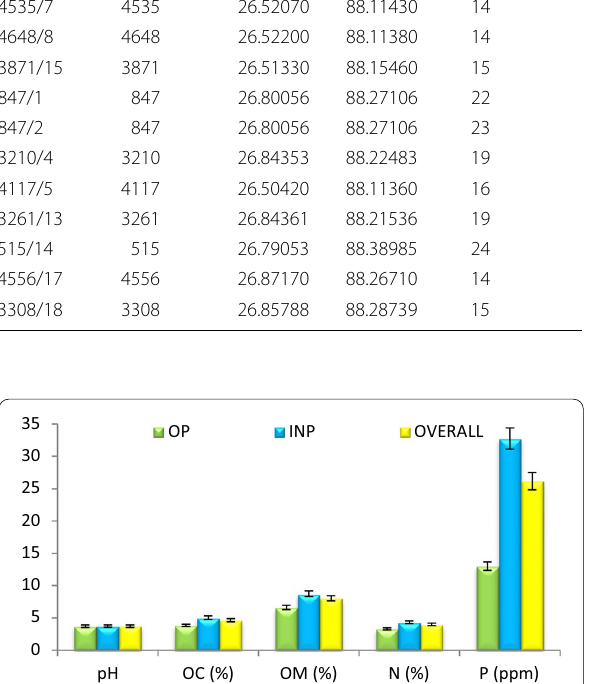
Fig. 1 Soil analysis data (average data) of OP, INP and